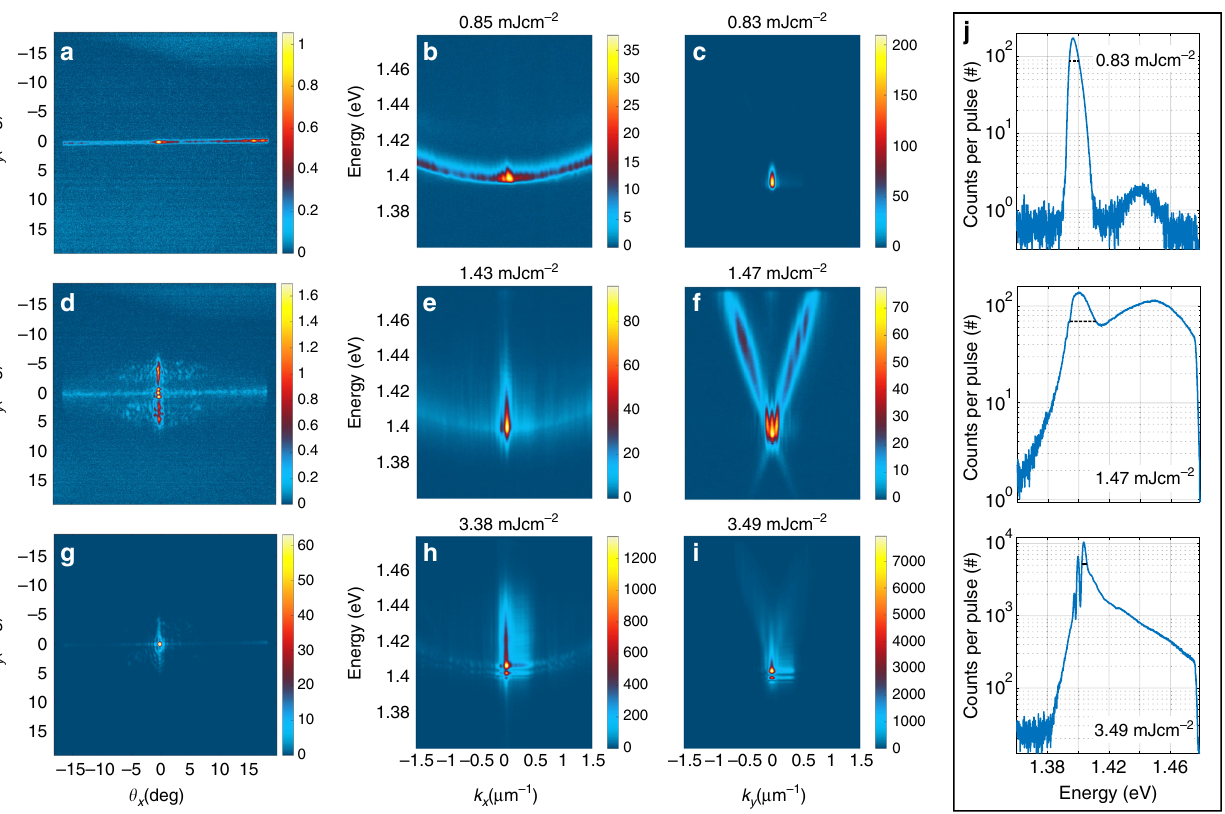
Fig. 3 Momentum space images and spectra. First column: 2D momentum ( k -)space images. Second and third column: k -space spectrum in the TM and TE mode directions, respectively. The spectra of the TM and TE modes correspond to horizontal and vertical slices of the 2D k -space spectrum, respectively. The pump fl uence is a – c 0.85 mJ cm − 2 , d – f 1.5 mJ cm − 2 , g – i 3.5 mJ cm − 2 , as in Fig. 2. The images and the corresponding line spectra are integrated over 500 ( c ), 330 ( f ), and 20 pulses ( i ). The horizontal stretching of the emission peaks in h , i are CCD blooming artifacts. j Population distribution in the TE mode integrated from ( c , f , i ) along k y . FWHMs are indicated with dashed black lines: 6.3, 17, and 3.3 meV with increasing pump fl uence. The results for the full range of pump fl uences are presented in Supplementary Movie